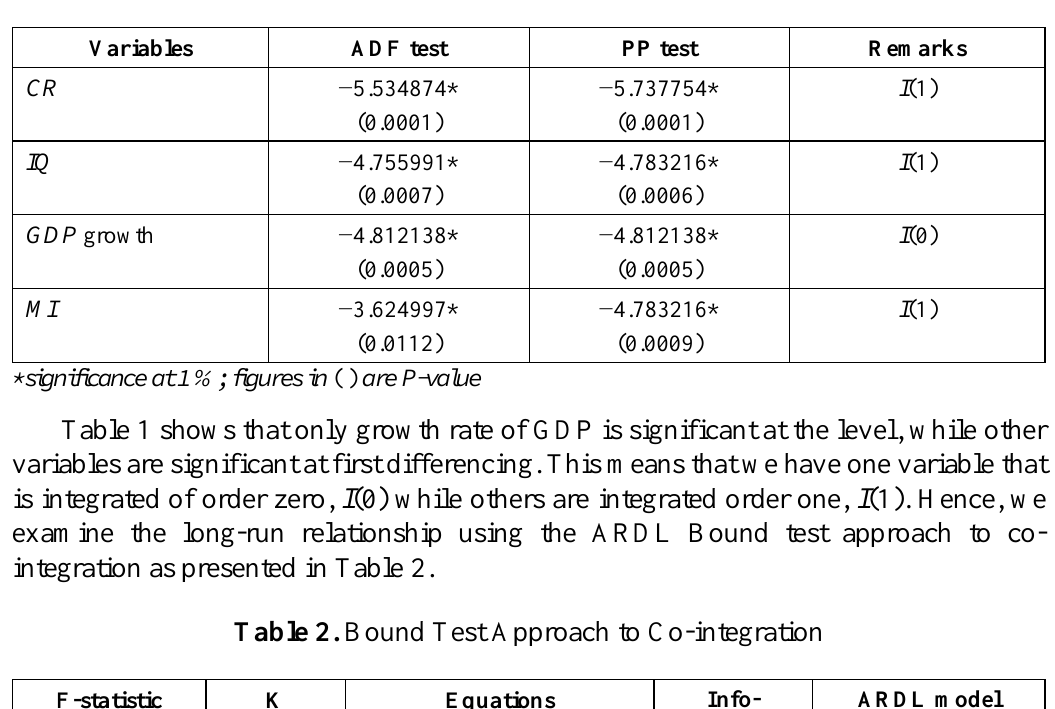
Table 1. Unit Root Test